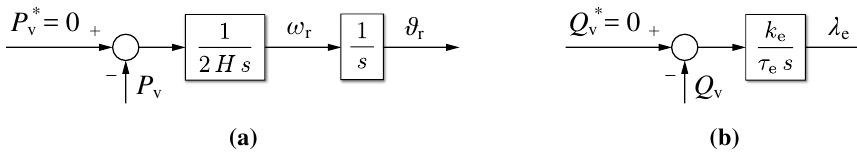
Figure 9. S-VSC block diagrams of the simplified swing equation ( a ) and the excitation control ( b